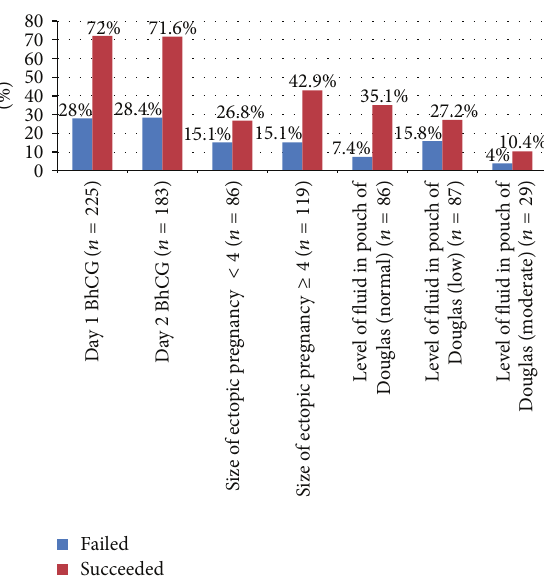
Figure 4: Predictors of failure of medical